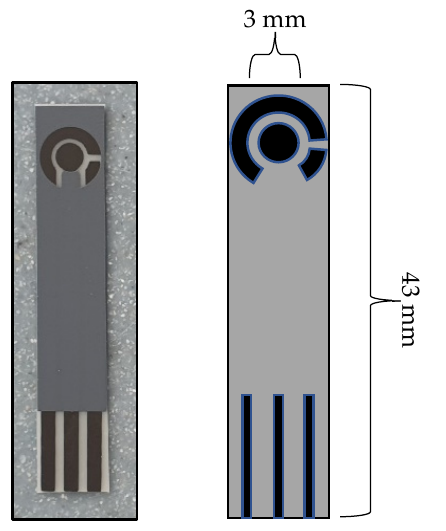
Figure 2. Schematic showing the complete C-MWCNT/DAO/EDC-NHS/GA SPEs ( Left ), and graphical depiction showing the sizes of the sensor ( Right ).